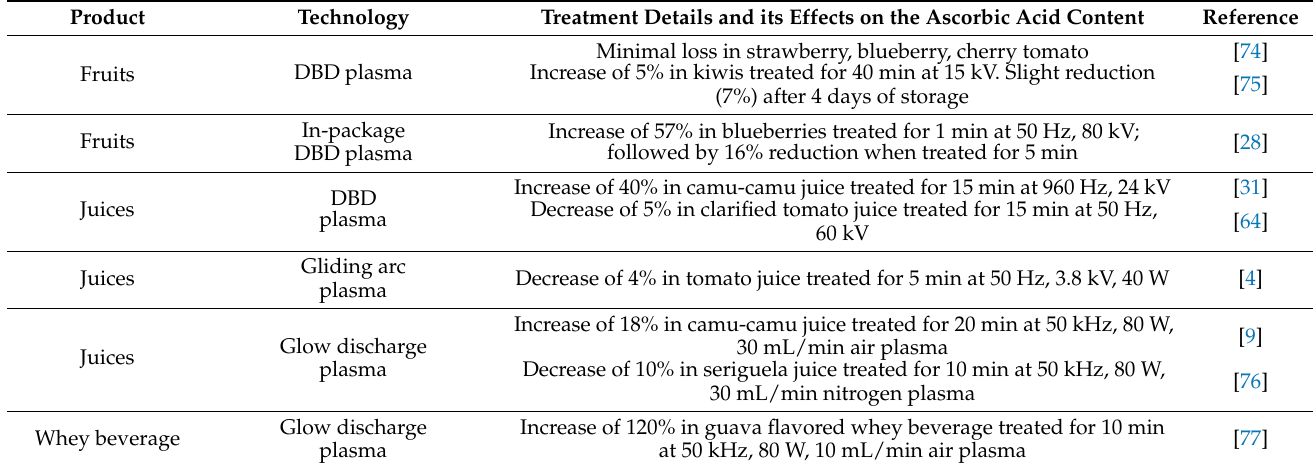
Table 2. Changes in ascorbic acid induced by cold plasma application.